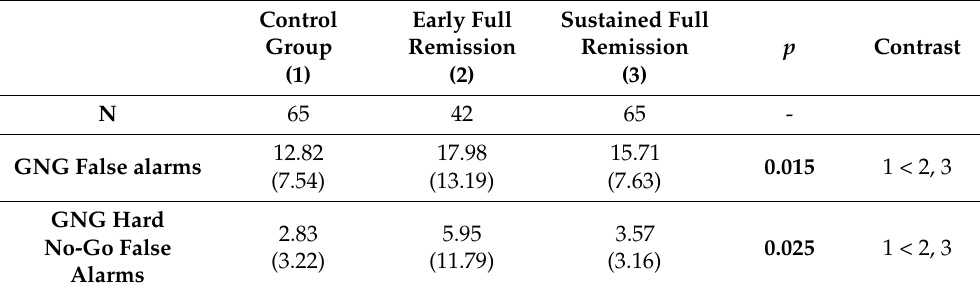
Table 3. Descriptive statistics and group differences on indices of impulsive